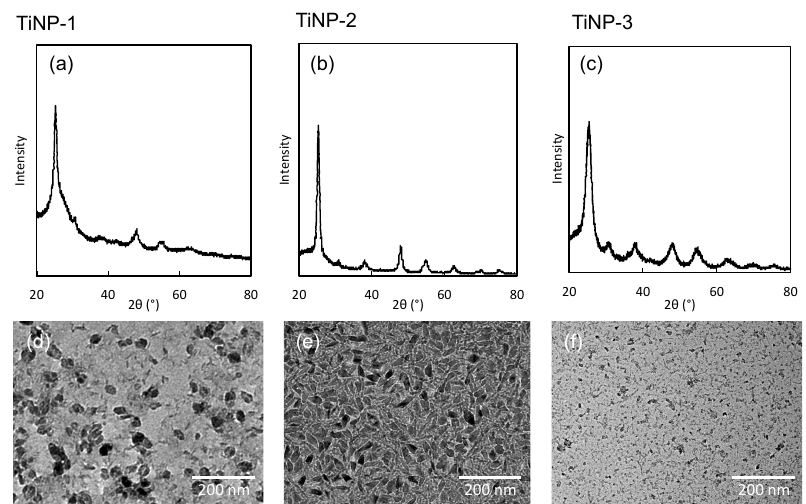
Figure 1. XRD patterns ( a – c ) and TEM images ( d – f ) of titanium oxide nanoparticles. TiNP-1 ( a , d ), TiNP-2 ( b , e ), and TiNP-3 ( c , f ).